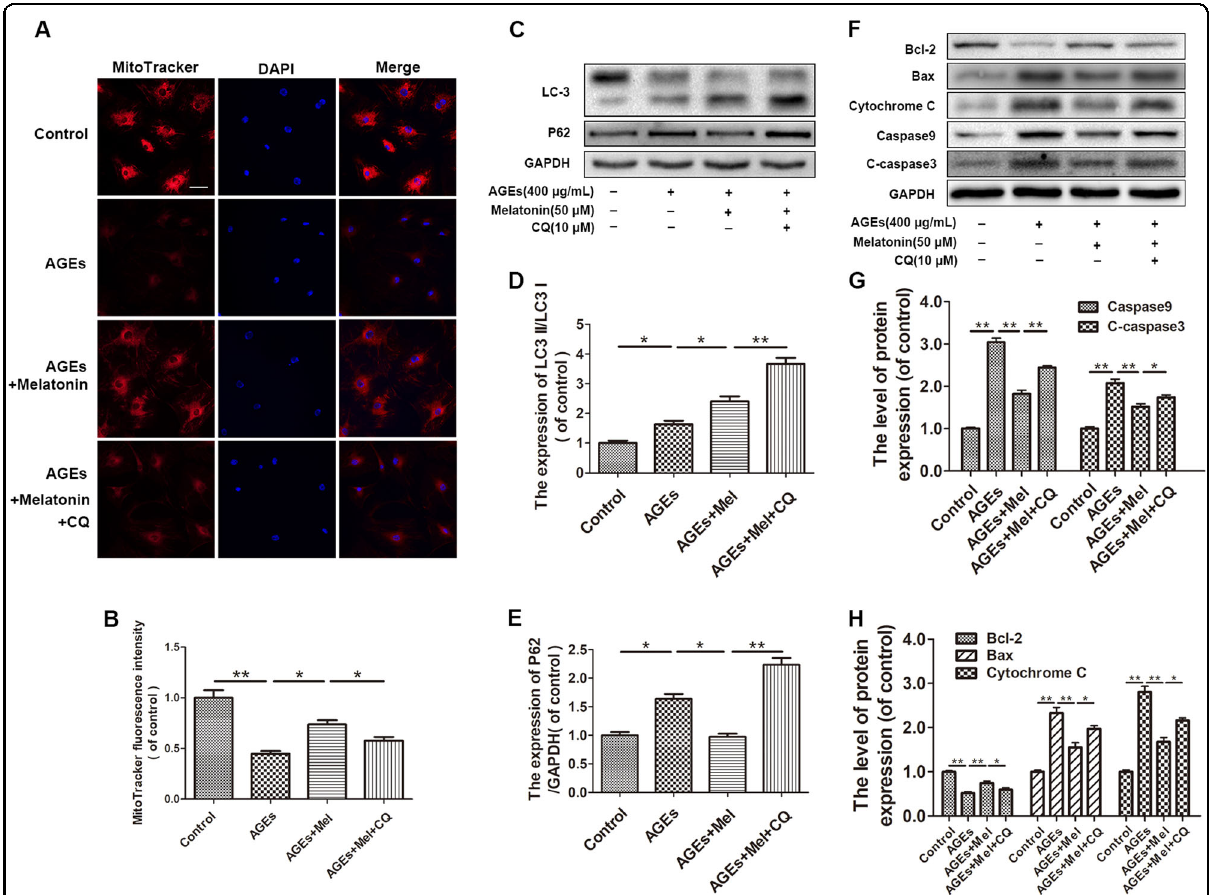
Fig. 3 The anti-apoptotic effect of melatonin is related to autophagy fl ux in AGE-treated EPCs. EPCS were untreated or treated with AGEs (400 μ g/mL) alone, melatonin (50 μ M) + AGEs (400 μ g/mL), or AGEs (400 μ g/mL) + melatonin (50 μ M) combined with chloroquine (CQ; 10 μ M). a , b Mitochondrial membrane potential was detected using MitoTracker Red CMXRos, and nuclei were stained with Hoechst. Scale bar, 25 μ m. c , e Protein expression levels of LC3, p62, and GAPDH in EPCs of each group treated as described above. f , h Protein expression levels of Bcl-2, Bax, cytochrome c, caspase-9, cleaved caspase-3, and GAPDH in EPCs of each group treated as described above. Data are presented as the mean ± SEM. Signi fi cant differences between the treatment and control groups are indicated as ** P < 0.01 or * P < 0.05. n =